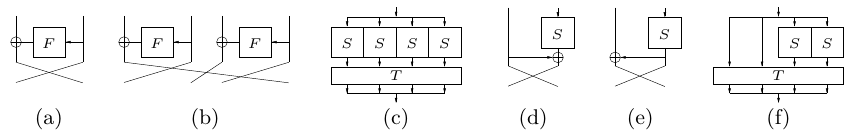
Figure 1: Different blockcipher structures. (a) Feistel network; (b) multi-line generalized Feistel, with 4 chunks; (c) the normal SPN; (d) Misty-L; (e) Misty-R; (f) partial